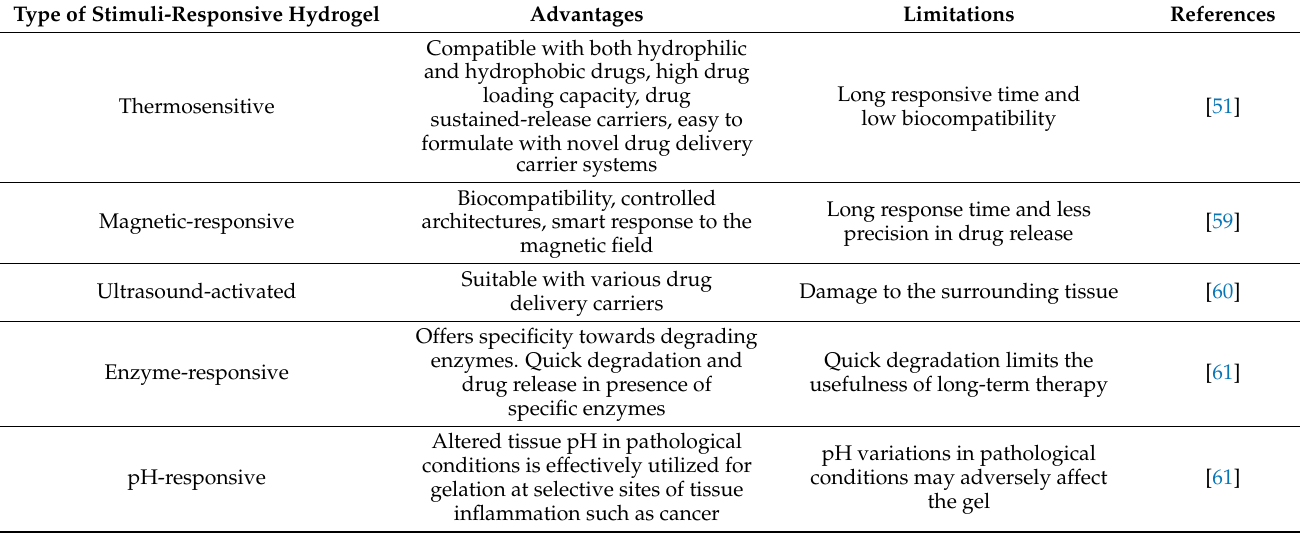
Table 2. Stimuli-responsive hydrogels with their advantages and